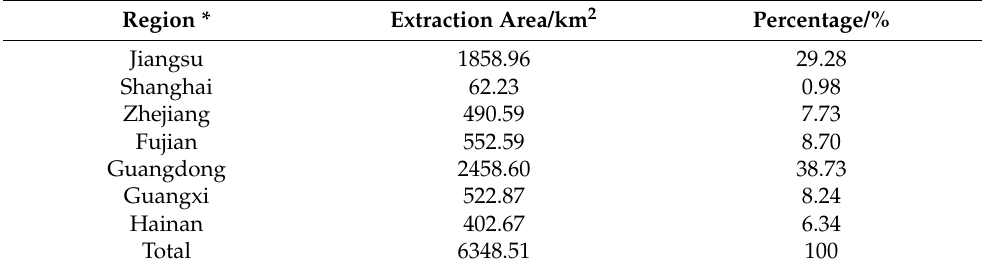
Table 2. Aquaculture pond extraction